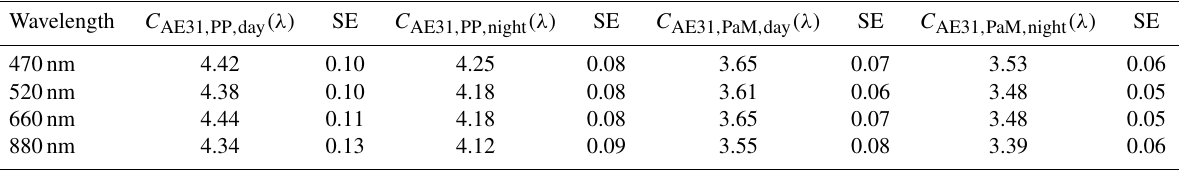
Figure 3. Scatterplot of b ATN_AE31 (λ) vs. b abs_PP (λ) (left charts) and vs. b abs_PaM (λ) (right charts) at 470, 520, 660, and 880nm (from top to bottom). Table 4. Multiple-scattering enhancement parameter and standard error (SE) for AE31 at different wavelengths calculated separately for the day and night datasets using PP ( C AE31_PP_day and C AE31_PP_night , respectively) and PaM ( C AE31_PaM_day and C AE31_PaM_night , respectively)